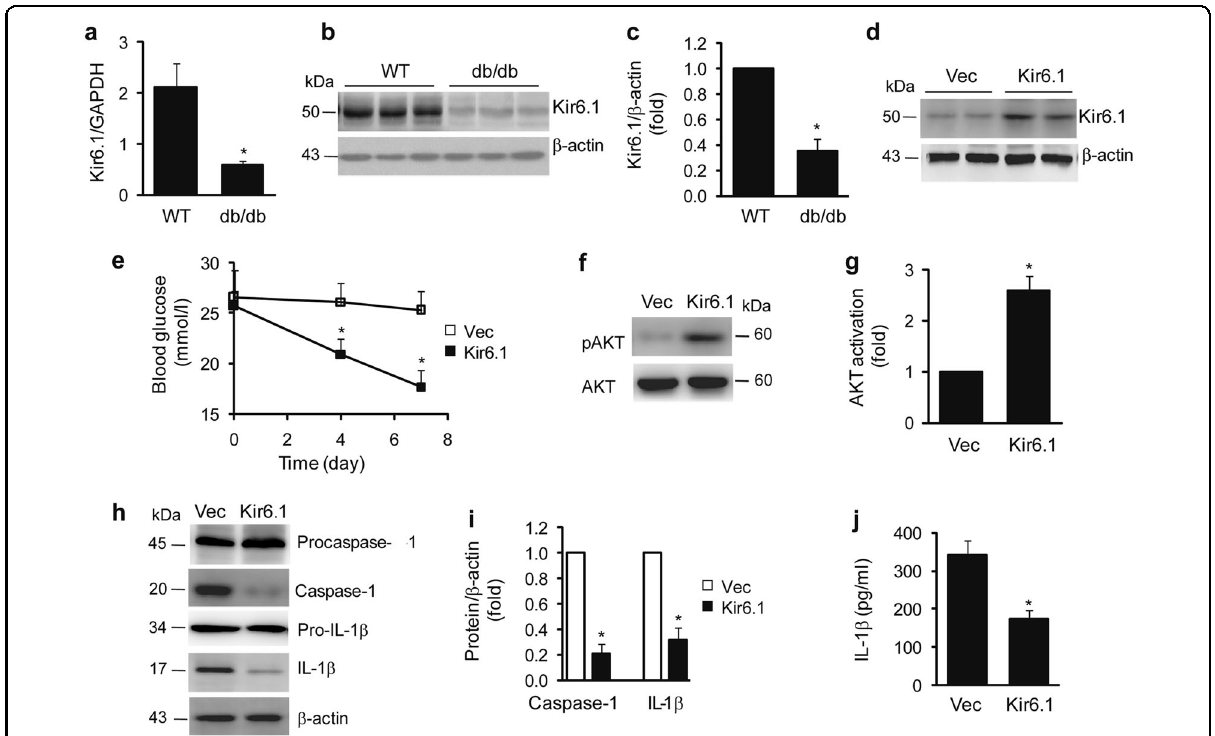
Fig. 6 Kir6.1 is downregulated, and rescue of Kir6.1 expression improves insulin resistance in db/db mice. a Downregulation of Kir6.1 in the livers of db/db mice detected by qPCR ( n = 6). b Representative immunoblots showing the reduction in Kir6.1 in the livers of db/db mice. c Quanti fi cation of data shown in ( b ); n = 6. The data shown are the mean ± SEM. * p < 0.05 vs WT. d Expression of Kir6.1 in the livers of db/db mice after injection with lentivirus for 7 days. e Kir6.1 expression reduced the basal blood glucose level in db/db mice; n = 6. f Representative immunoblots showing that Kir6.1 enhanced the activation of AKT in the liver of db/db mice. g Quanti fi cation of data shown in ( f ); n = 4. h Kir6.1 inhibited NLRP3 in fl ammasome activation in the livers of db/db mice. i Quanti fi cation of data shown in ( h ). j Kir6.1 attenuated serum IL-1 β in db/db mice; n = 6. The data shown are the mean ± SEM. * p < 0.05 vs